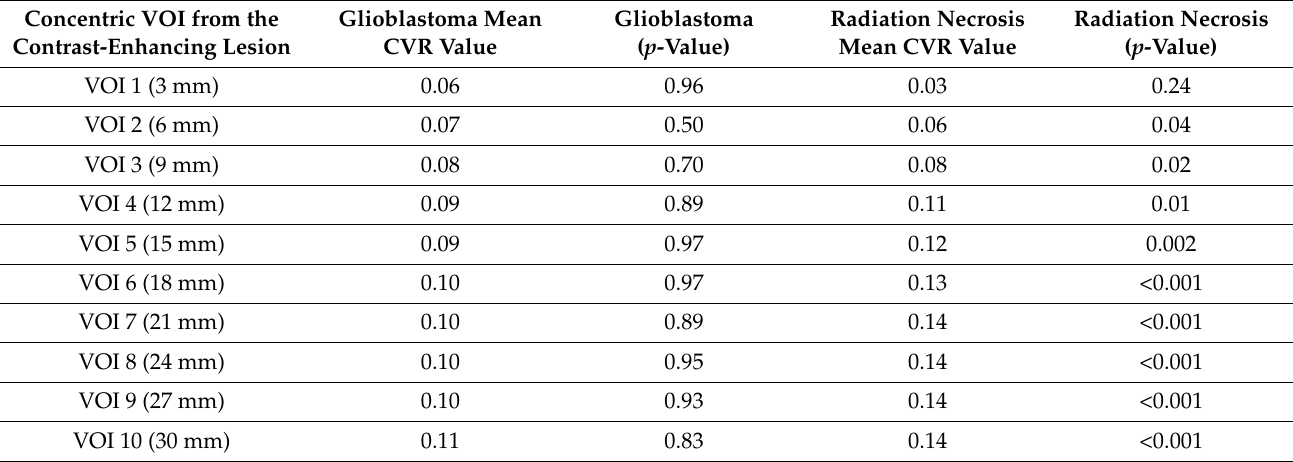
Table 2. Comparison of intralesional versus perilesional BOLD-CVR